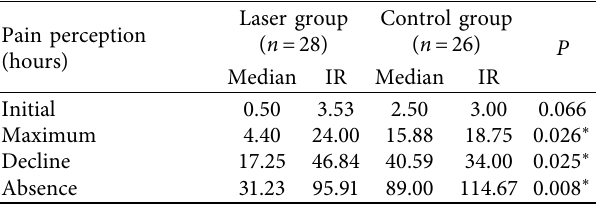
Table 3: Intergroup comparison of the elapsed time (hours) as a function of pain perception (initial, maximum, decline, and ab- sence) (nonparametric Mann–Whitney